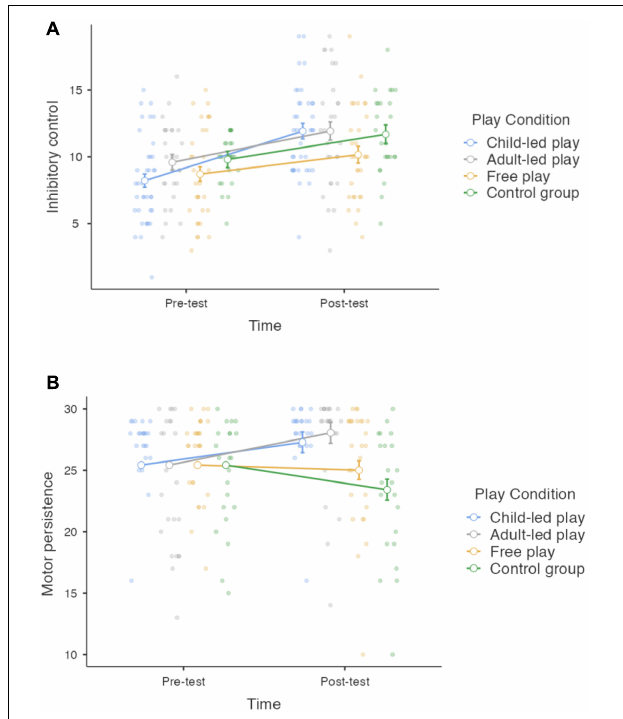
FIGURE 1 | Representation of marginals means and error bars (representing confidence interval of the mean) for (A) inhibitory control and (B) motor persistence by Time and Play